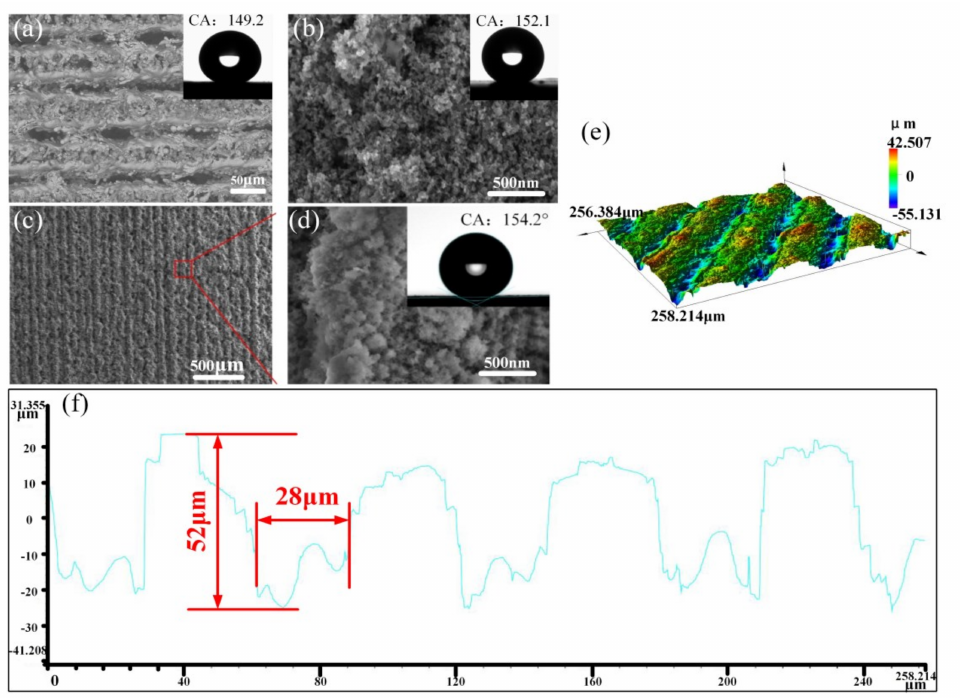
Figure 3. Surface topography of each structure. ( a ) The SEM of the microstructure; ( b ) the SEM of the nanostructure; ( c , d ) the SEM of hierarchical structure; ( e ) 3D morphology of the HS surface; ( f ) height profile of the HS